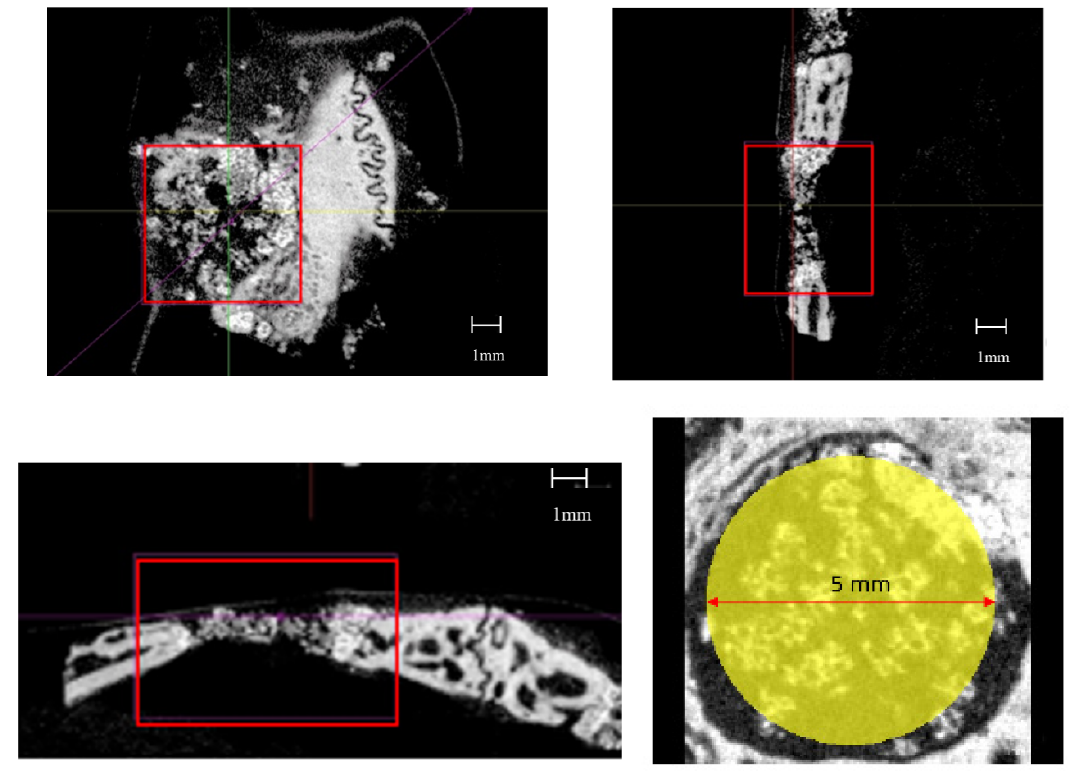
Figure 2. Micro – CT images and ROI. Figure 2. Micro–CT images and